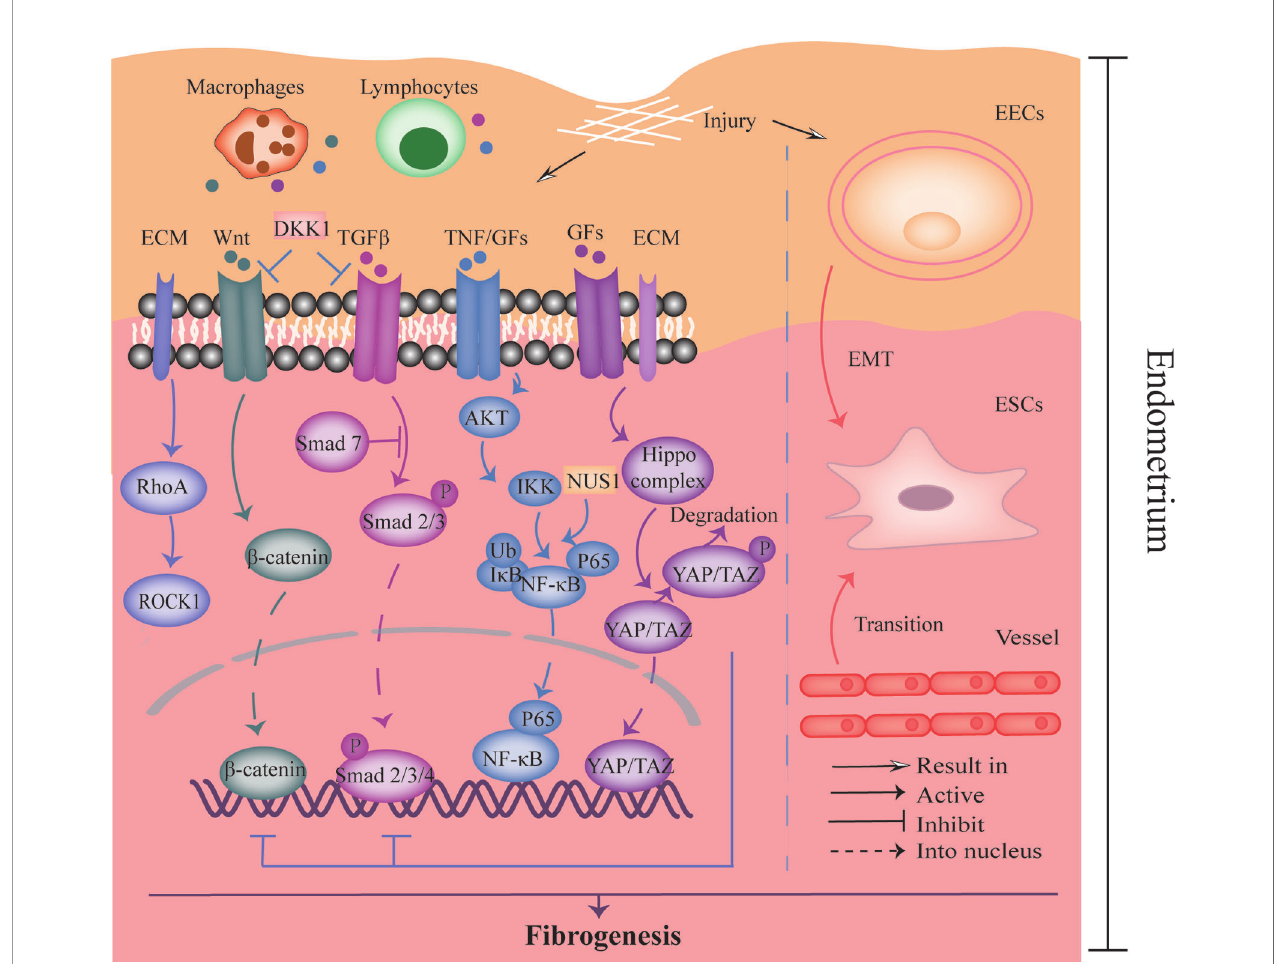
FIGURE 2 | The pathogenesis of IUA. The left part showed the crosstalk of TGF- b , Wnt, NF- k B, Hippo, and RhoA/ROCK signaling pathways, which was relevant to endometrial fi brosis. The right part revealed the process of EMT and endothelial to mesenchymal transition that was involved in fi brogenesis. DKK-1, Dickkopf-1; ECM, Extracellular matrix; GFs, Growth factors; TNF, Tumor necrosis factor; EECs, Endometrial epithelial cells; ESCs, Endometrial stromal cells; EMT, Epithelial- mesenchymal